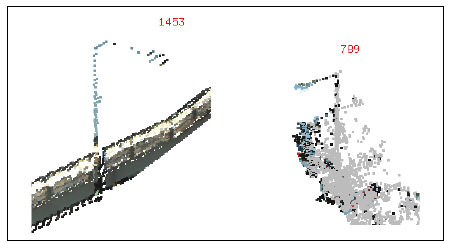
Figure 10. Undetectable pole-like objects by our method